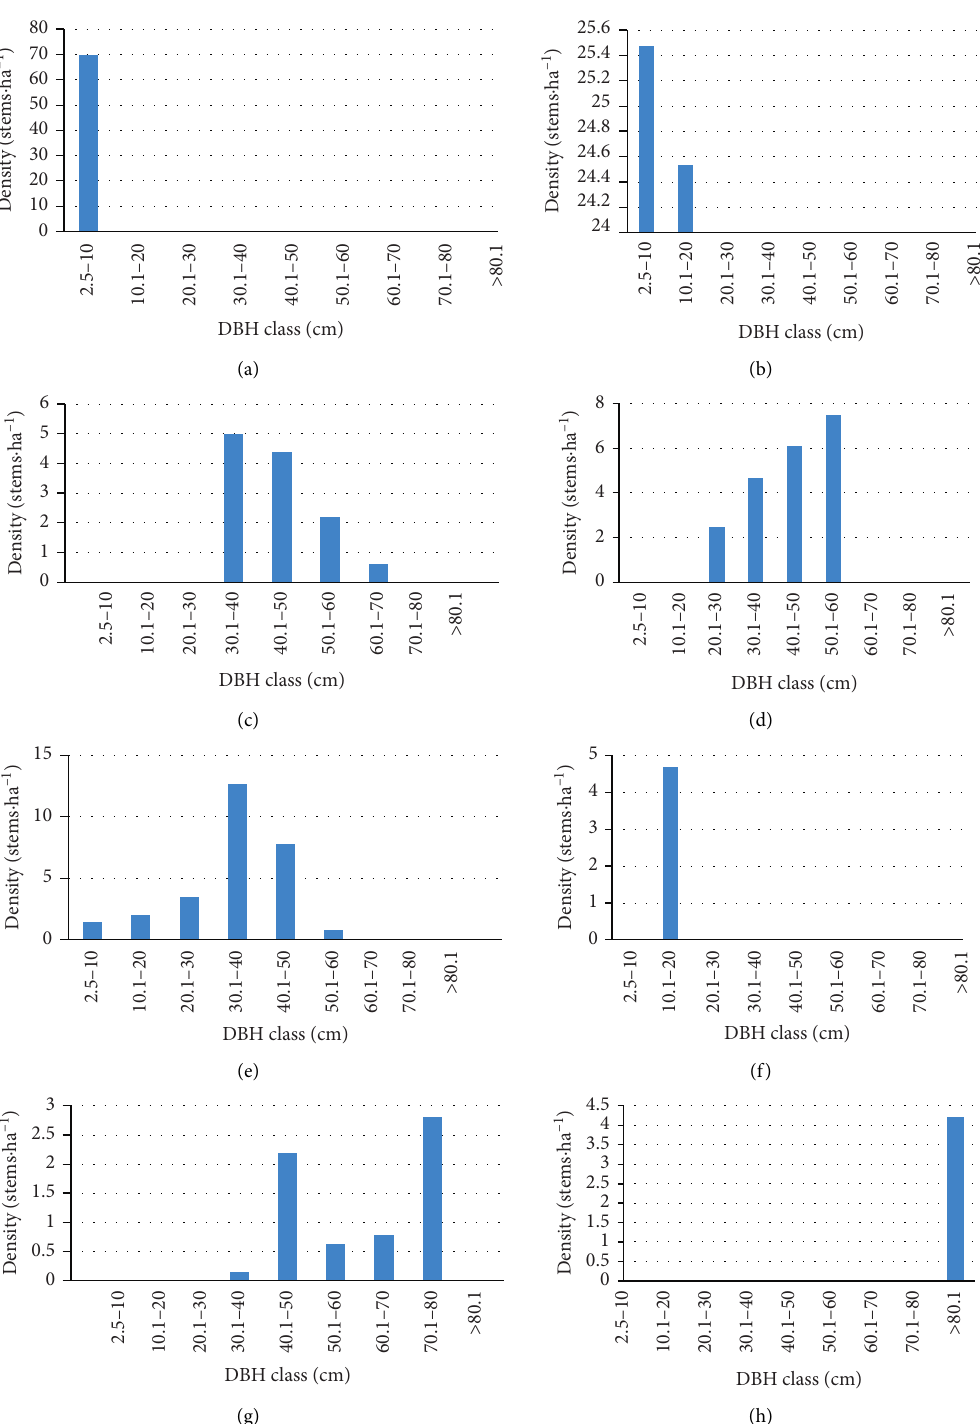
Figure 9: Representative population structure patterns of each tree species in Kafta Sheraro National Park. (a) Acacia mellifera , (b) Combretum hartmannianum , (c) Anogeissus leiocarpus , (d) Tamarindus indica , (e) Balanites aegyptiaca , (f) Diospyros mespiliformis , (g) Sterculia africana , and (h) Adansonia digitata